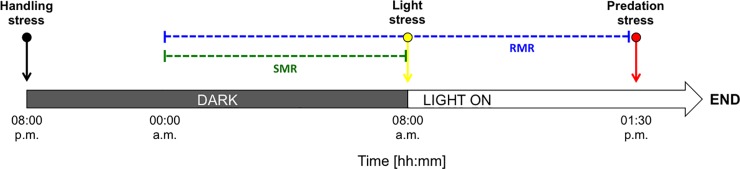
Schematic representation of the time setup of one experimental run.SMR: Standard metabolic rate (green dashed line). RMR: Routine metabolic rate (blue dashed line). The arrows indicate the time of the respiratory cycles that were used for assessing handling stress response (black; 08:00 p.m.), light stress response (yellow; 08:00 a.m.), and predation stress response (red; 01:30 p.m.). The time spans used for assessing SMR (00:00 a.m.– 08:00 a.m.) and RMR (00:00 a.m.– 01:30 p.m.) are given in dashed lines (green: SMR; blue: RMR). The experimental runs were conducted on five consecutive days to finally reach n = 13.